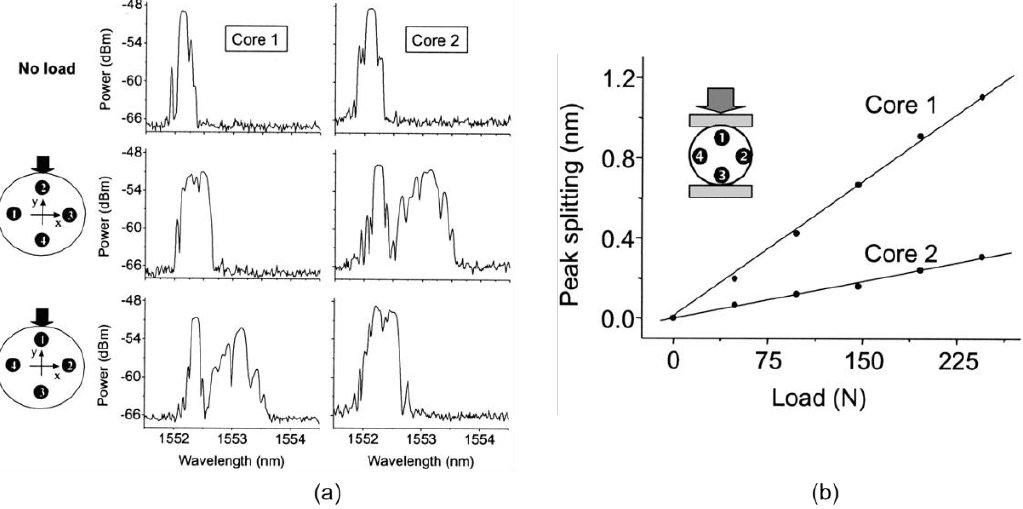
Figure 12. Birefringence-induced peak splitting due to increasing loading. Adapted with permission from Ref. [44] © Optica Publishing Group.